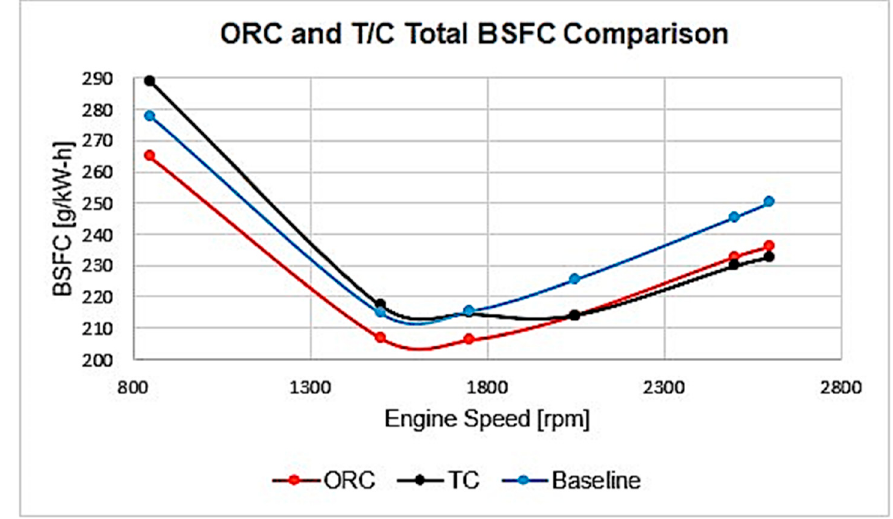
Figure 21. Comparison of total BSFC between ORC and T / C in relation to engines’ speed.